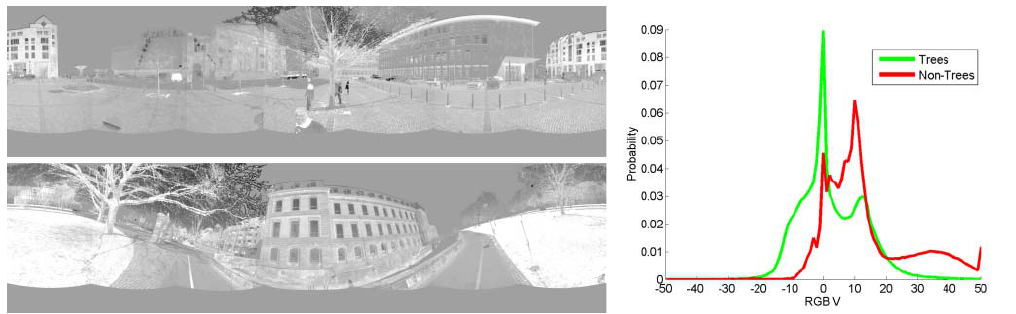
Figure 11. v values of the Luv representation of the color channel, and their tree/non-tree distribution.